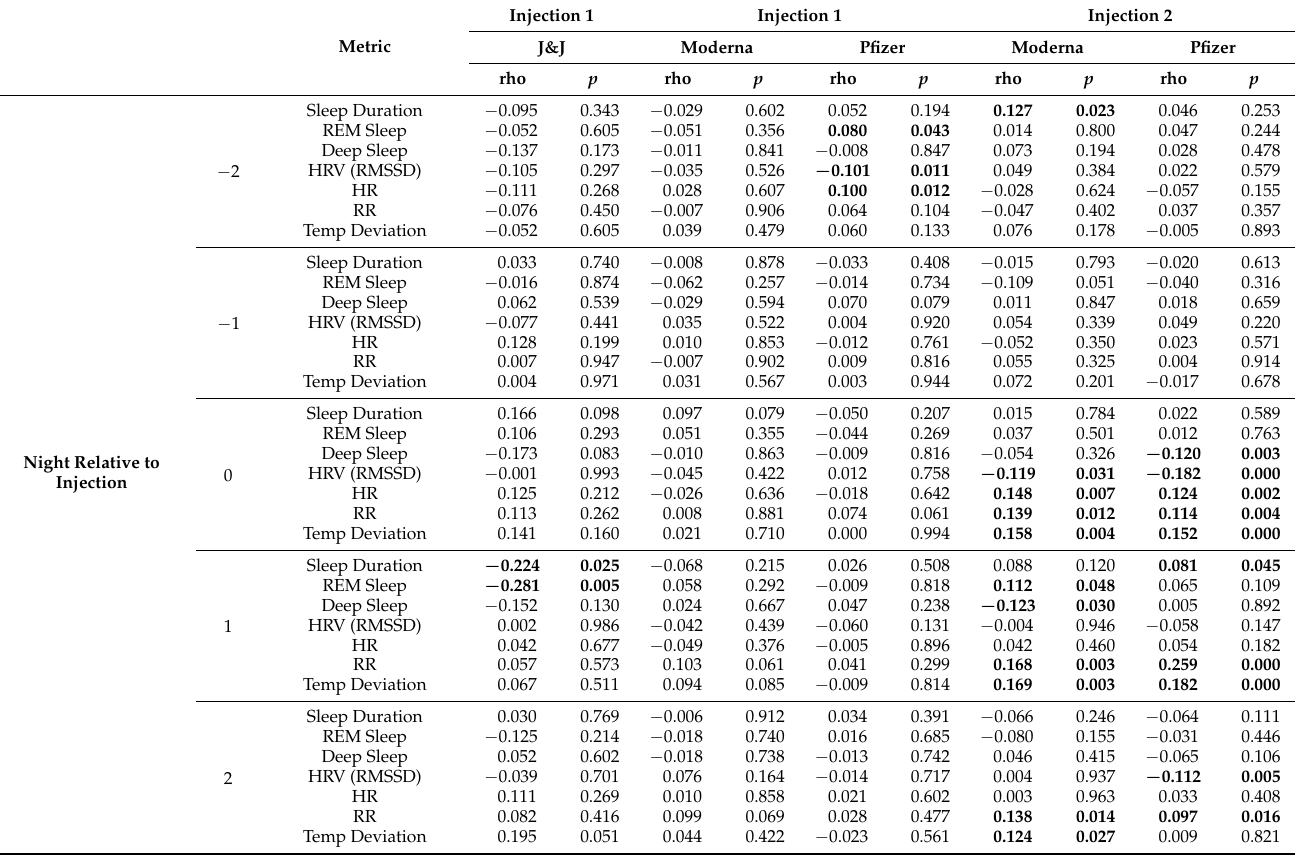
Table 4. Spearman rank order correlations between RBD antibody responses and device-generated metrics on nights before and after vaccine injections, adjusted for the pre-vaccination baseline